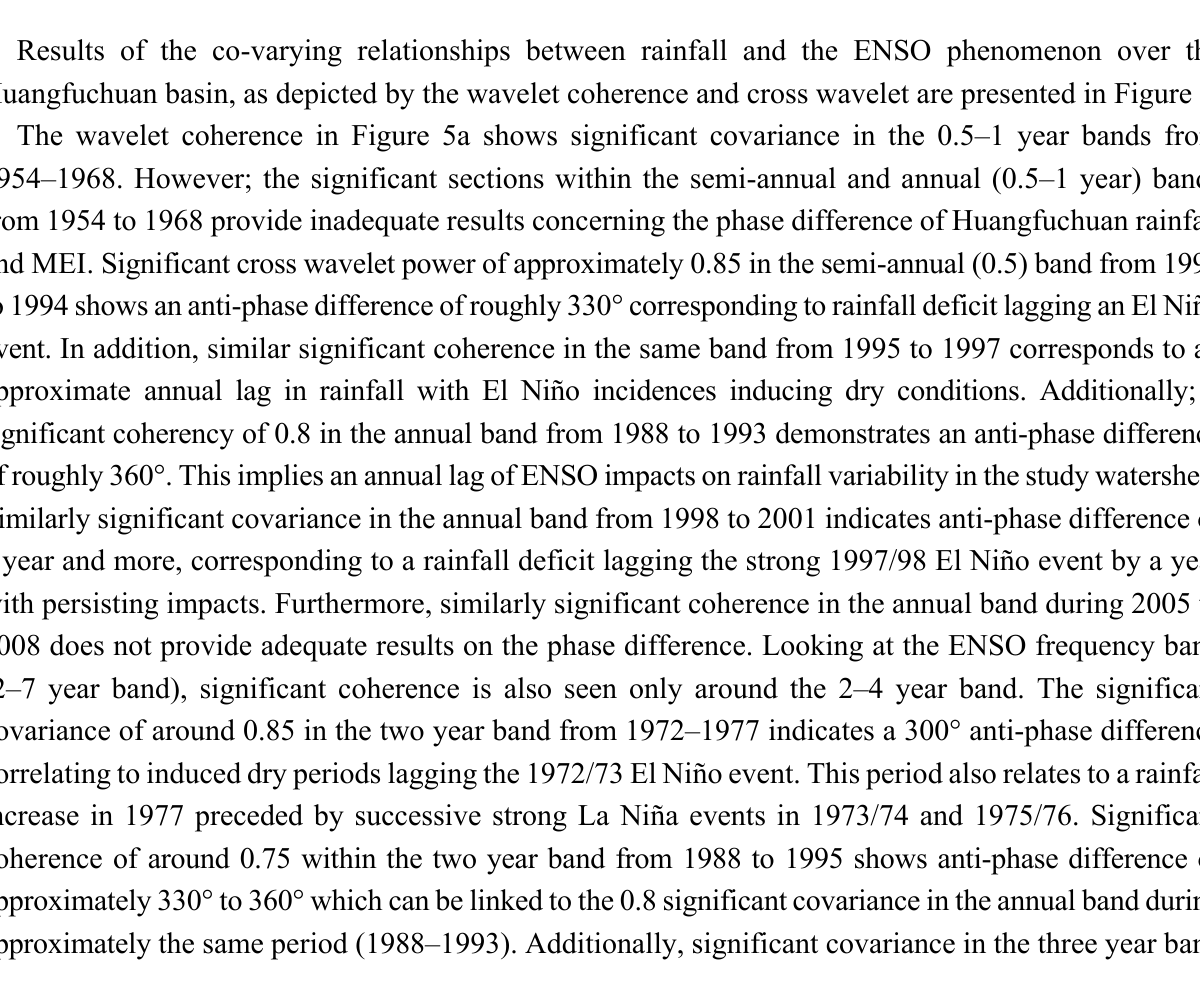
Figure 6. Relationship between Huangfuchuan rainfall and MEI showing the average annual rainfall variance and the 2–7 year variance of MEI. The black continuous curve shows rainfall and black dashed curve shows